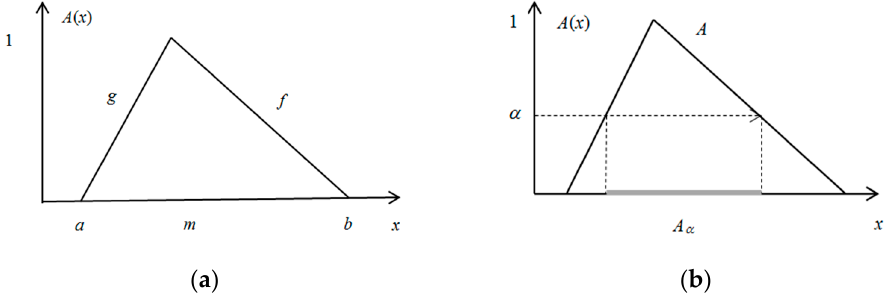
Figure 1. Membership function of a fuzzy set ( a ) and α -cut of a fuzzy set ( b ).